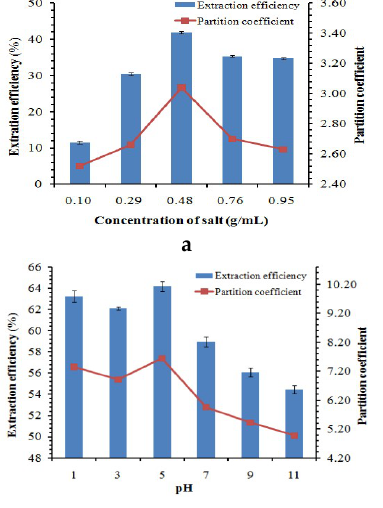
Figure 4. Effect of ( a ) NaH 2 PO 4, ( b ) (NH 4 ) 2 SO 4, ( c ) system pH at room temperature on the extraction efficiencies and partition coefficient.